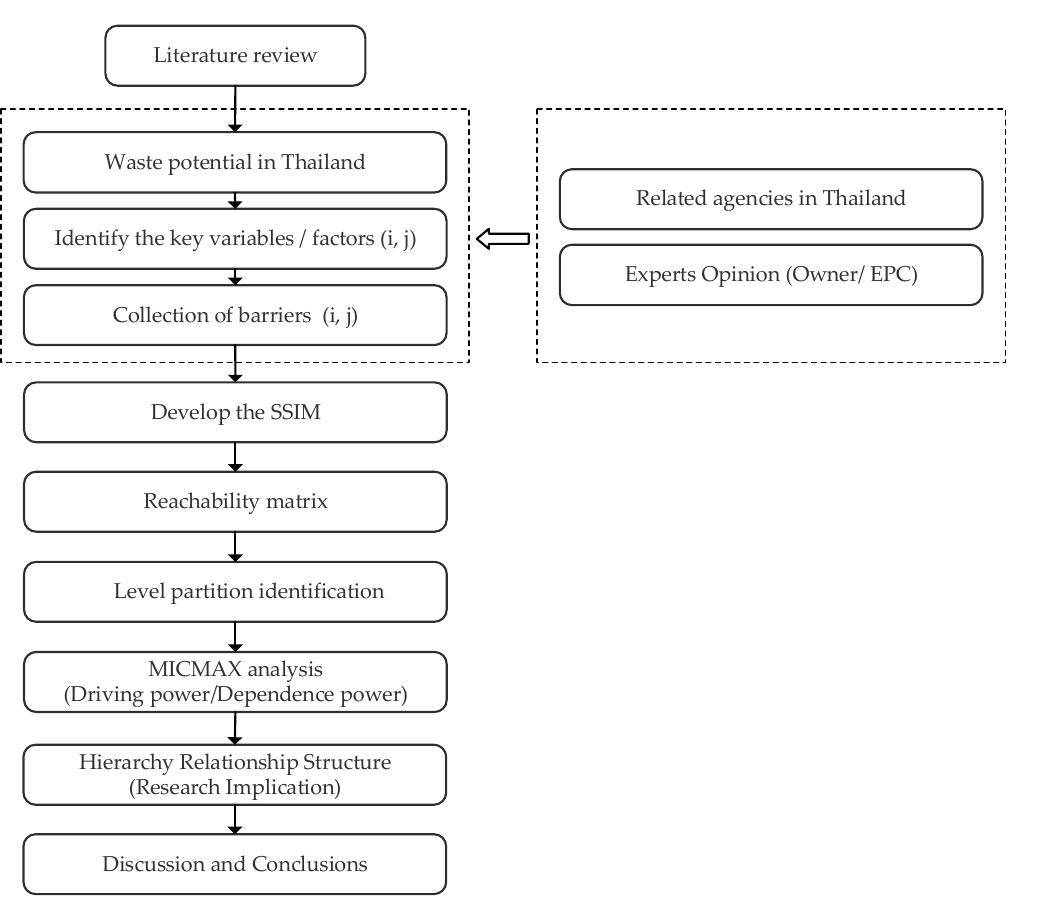
Figure 4. The ISM structural flow of this research.